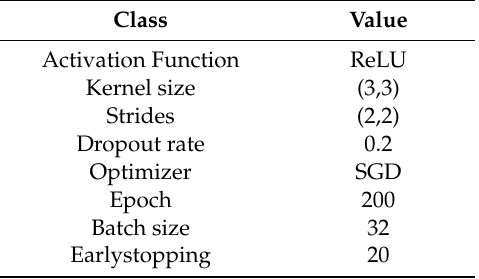
Figure 4. CNN model structure; ( a ) after placing the convolutional layer and the max-pooling layer twice, place the dropout layer once and repeat training twice; ( b ) place the convolutional layer, the max-pooling layer and dropout layer once and repeat training twice; ( c ) fully-connected and dropout layers are alternately placed and softmax is applied to the output layer. Table 8. CNN Model Setup Value.